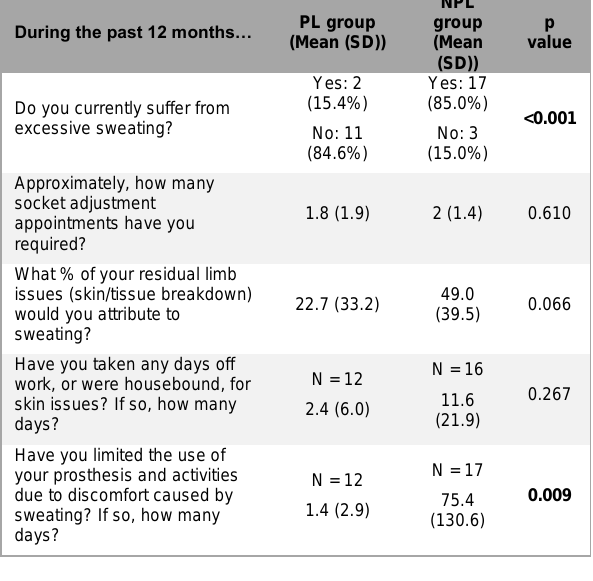
During the past 12